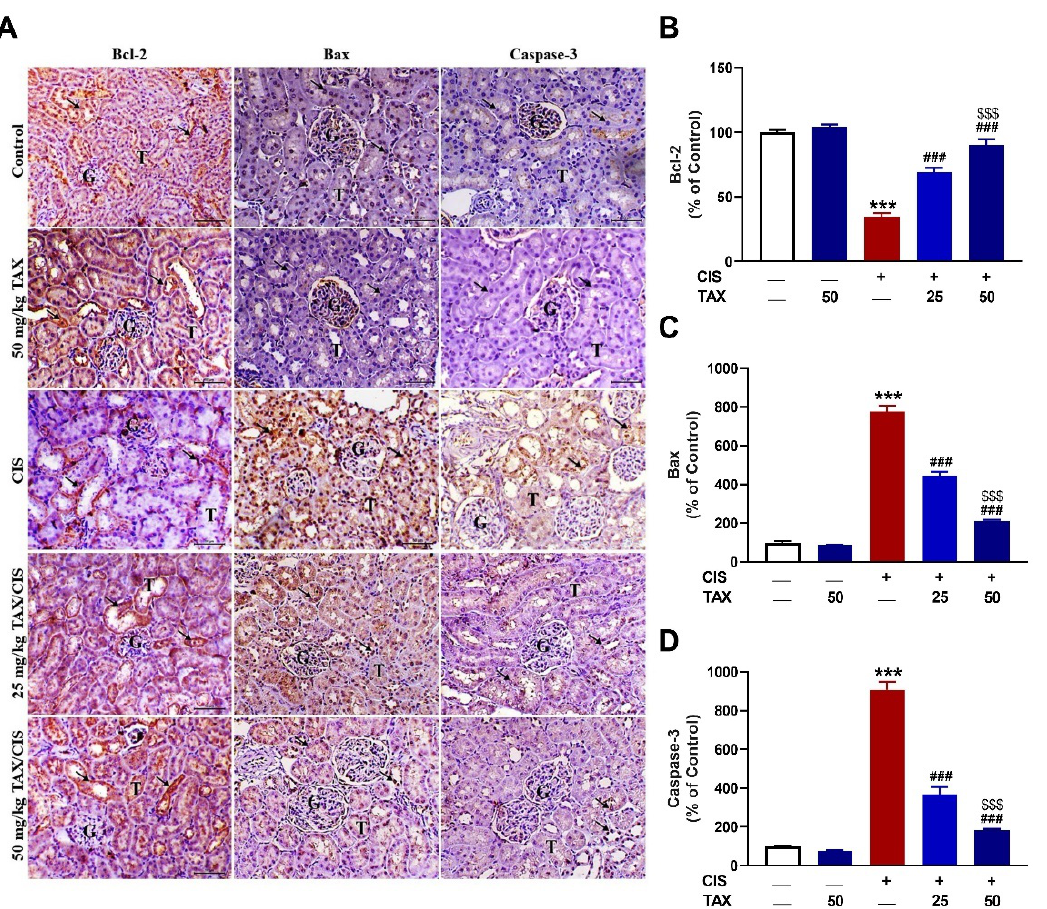
Figure 6. TAX prevented CIS-induced apoptosis in the kidney of mice. ( A ) Photomicrographs of sections in the kidney of control and TAX-treated mice showing marked expression of Bcl-2, and mild expression of Bax and caspase-3 (arrow), of CIS-administered mice showing decreased Bcl-2, and markedly increased Bax and caspase-3 (arrow), and of CIS-administered mice treated with 25 and 50 mg/kg TAX showing marked increase in Bcl-2, and noticeable decrease in Bax and caspase-3 (arrow) (G, glomeruli; T, tubules—scale bar = 50 µm). ( B – D ) Image analysis showing significant increase in Bcl-2 and decreased Bax and caspase-3 in CIS-administered mice treated with TAX. Data are mean ± SEM, ( n = 6). *** p < 0.001 versus Control, ### p < 0.001 versus CIS, and $$$ p < 0.001 versus TAX (25 mg/kg).